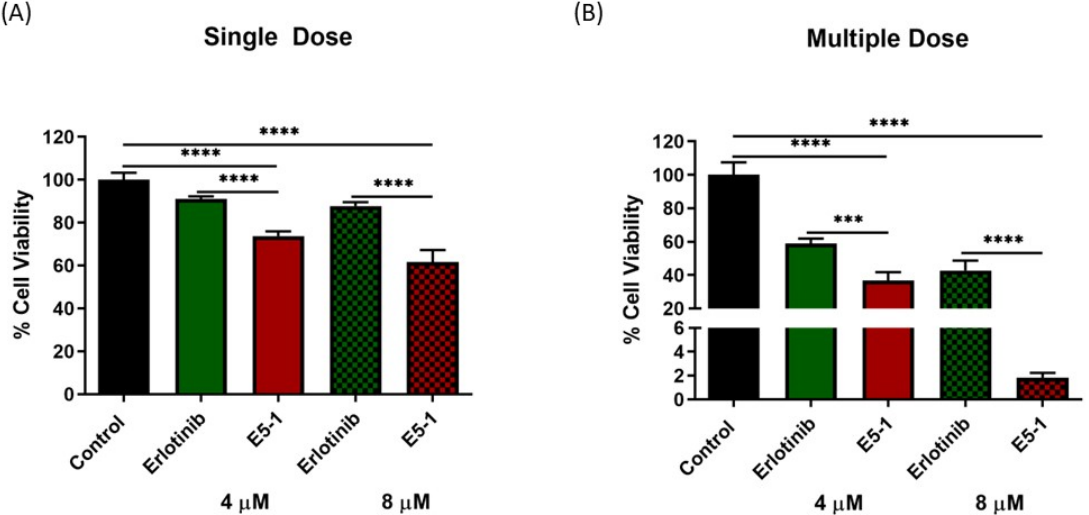
Figure 10. Cell viability study performed using CellTiter-Glo ® assay after single dose ( A ) and mul- tiple doses ( B ). At day 15, 100 µL of medium was removed and replaced with 100 µL of Cell Titer- Glo ® reagent in each spheroid well and the luminescence was measured. Results indicate the per- centage of cell viability after each treatment, and comparisons were made by considering the control as 100%. Signi fi cance between the groups was analyzed by one-way ANOVA and Tukey’s multiple comparisons test. Data represent mean ± SEM (n = 3). **** p < 0.0001, *** p < 0.001.